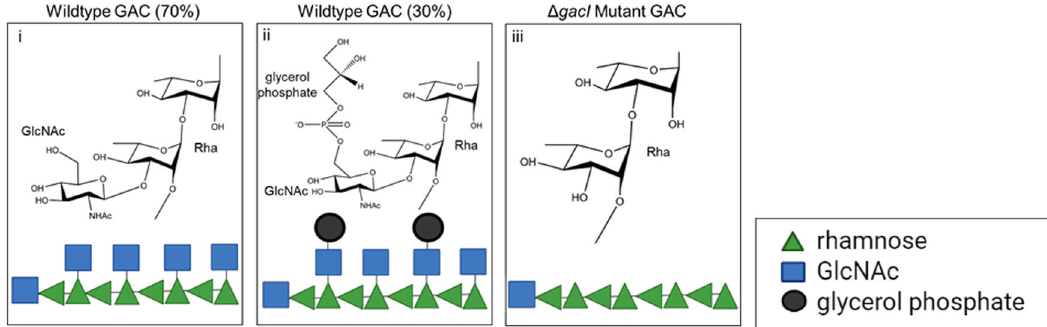
Fig. 1 Structures of the GAC trisaccharide repeating unit. GAC is composed of a polyrhamnose backbone and GlcNAc side chains, decorated with glycerol phosphate. The wildtype repeating unit is [3) α - L -Rha p (1 → 2)[ β - D -Glc p NAc(1 → 3)] α - L -Rha p ] for 70% of the repeating units (i), and 30% modi fi ed on GlcNAc side chains with glycerol phosphate (ii) [3)- α - L -Rha p -(1 → 2)[ β - D -Glc p NAc6P(S)Gro-(1 → 3)]- α - L -Rha p -(1 → 3)]. Δ gacI mutants and certain GAS strains passaged in mice have the repeating structure [3)- α -L-Rha p -(1 → 2) α -L-Rha p -(1 → 3)- α ] de fi cient in GlcNAc sidechains